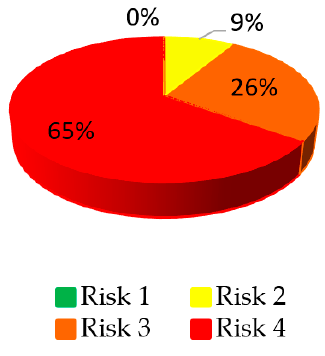
Figure 5. Risk Figure 5. Risk levels.